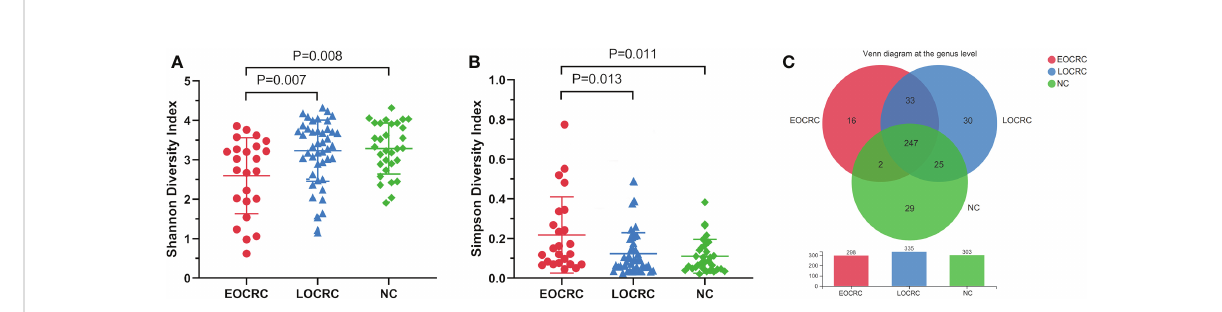
FIGURE 1 Alpha diversity analysis of gut microbiota in the three groups of patients. A : The comparison of Shannon index among the three groups. The Shannon index of the EOCRC group was signi fi cantly lower than the LOCRC group (P=0.007) and the NC group (P=0.008); B : The comparison of Simpson index among the three groups. The Simpson index of the EOCRC group was signi fi cantly higher than the LOCRC group (P=0.013) and the NC group (P=0.011); C : Venn diagram analysis of the three groups on the genus level. The three groups had 247 genera in common, with 16 unique genera in the EOCRC group, 30 unique genera in the LOCRC group and 29 unique genera in the NC